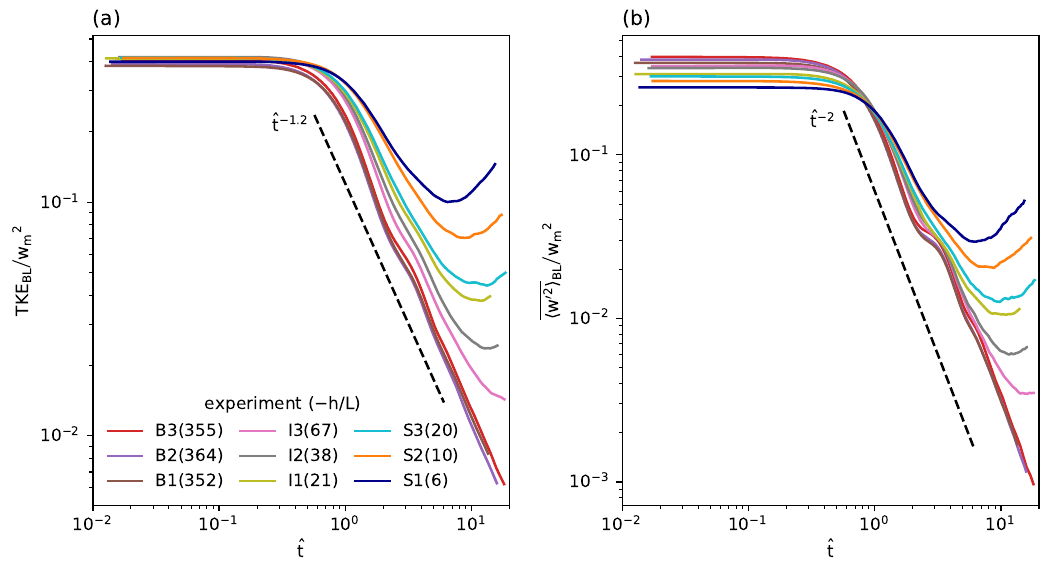
Figure 2. Time series of normalized ( a ) turbulent kinetic energy (TKE) and ( b ) vertical velocity variance, vertically averaged below z = h . The black dashed lines indicate decay rates following a power law. The dimensionless stability parameters are given in parentheses after each experiment